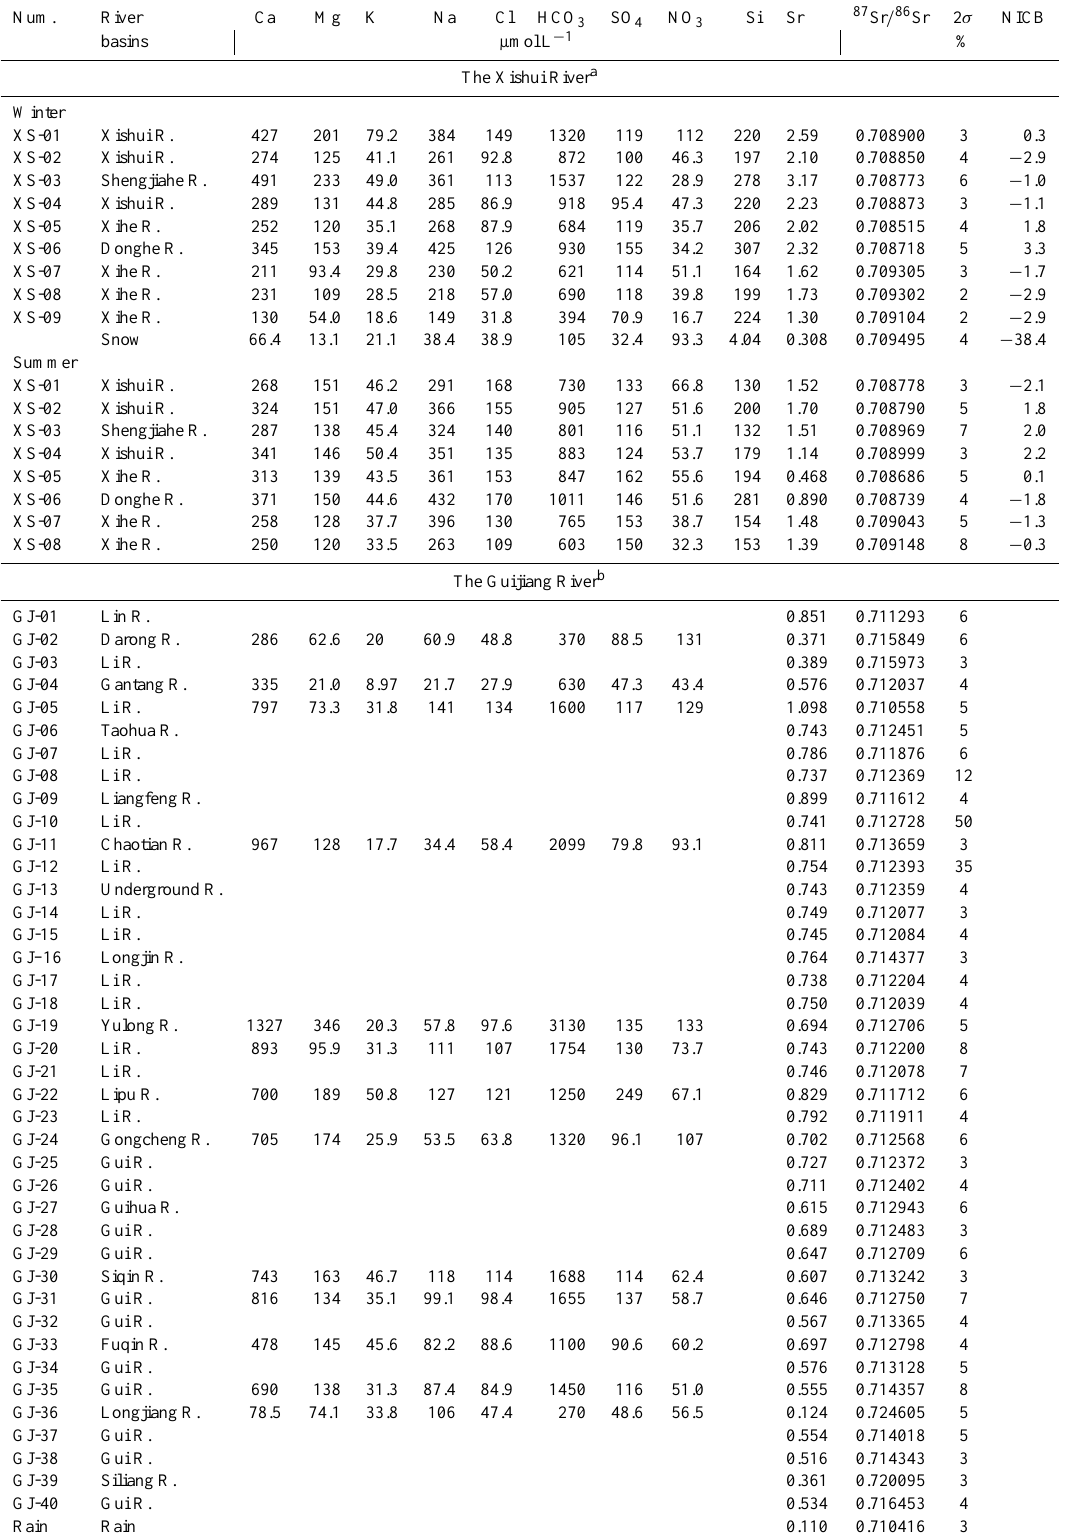
The Xishui River a